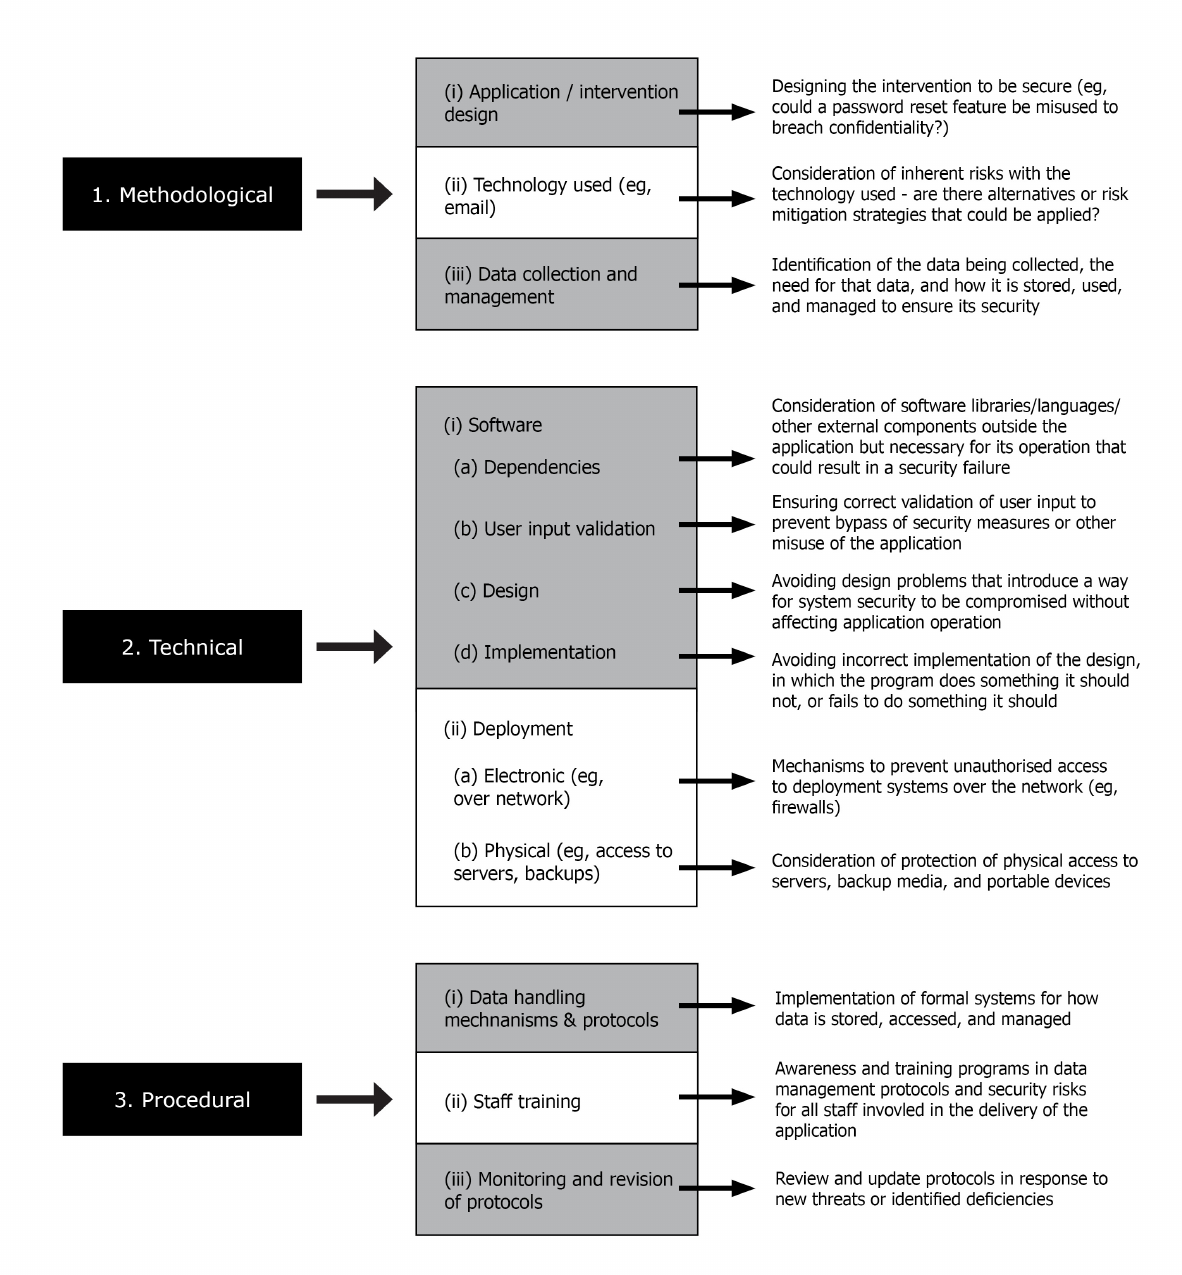
Figure 1. A summary of key security issues in the eHealth intervention